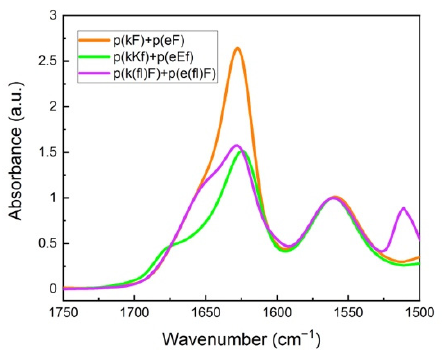
Figure 4. FTIR spectra of sequence pairs: p(kF) + p(eF), p(kKf) + p(eEf), and p(k(fl)F) + p(e(fl)F). The peak at around 1625 cm − 1 is characteristic of β -sheet formation, overlapping with the random coil conformation signal at around 1645 cm − 1 . Glutamic acid sidechain carbonyl stretching is observed at 1564 cm − 1 . The signal at 1510 cm − 1 and a low-intensity shoulder at 1603 cm − 1 are associated with the carbon-carbon stretching vibration of the fluoro-phenylalanine aromatic ring. Table 2. Deconvolution analysis of FTIR spectra for sequence pairs. The curve fitting procedure is applied using Origin software. The area under the curves is measured with the Gauss function. Each secondary structure percentage is calculated by dividing the area of its assigned peak by the total area in the 1610–1700 cm − 1 range. Peaks center around 1610, 1625, 1645, and 1680 cm − 1 are considered in the secondary structure